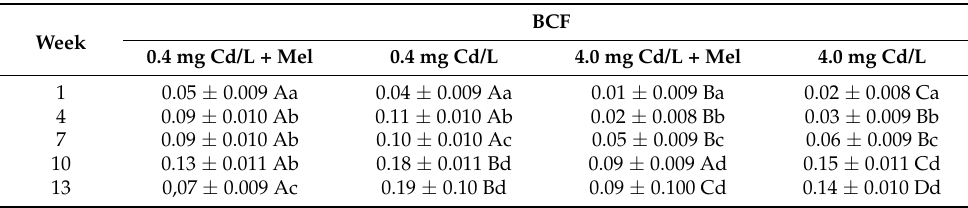
Table 6. Bioconcentration factors (BCF) in the muscles of female Prussian carp expos to different doses of cadmium for 1, 4, 7, 10, and 13